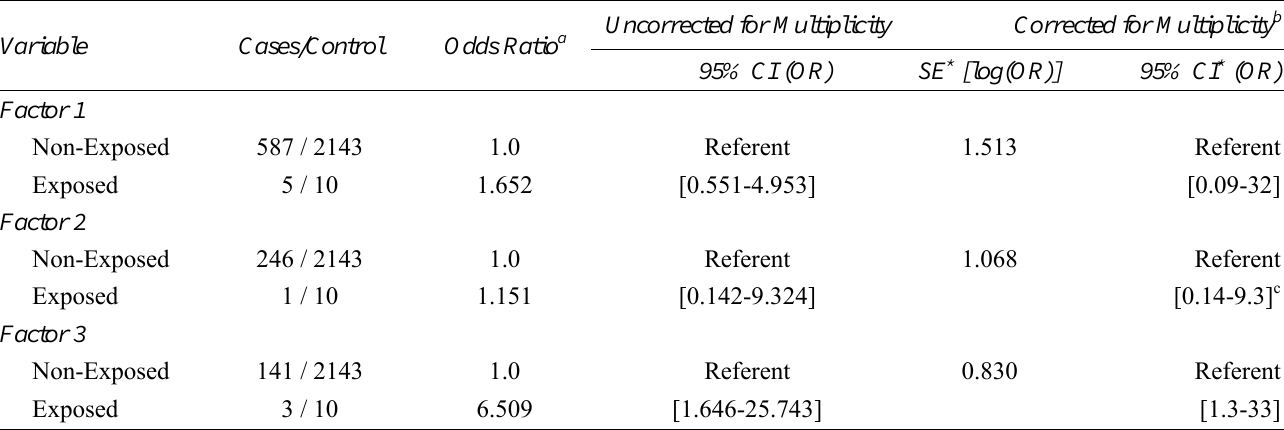
Table 1: Odds ratios (OR) and 95% confidence intervals (CI) for a hypothetical disease (D) and exposure to 3 dichotomously coded environmental risk factors, uncorrected and corrected for multiplicity